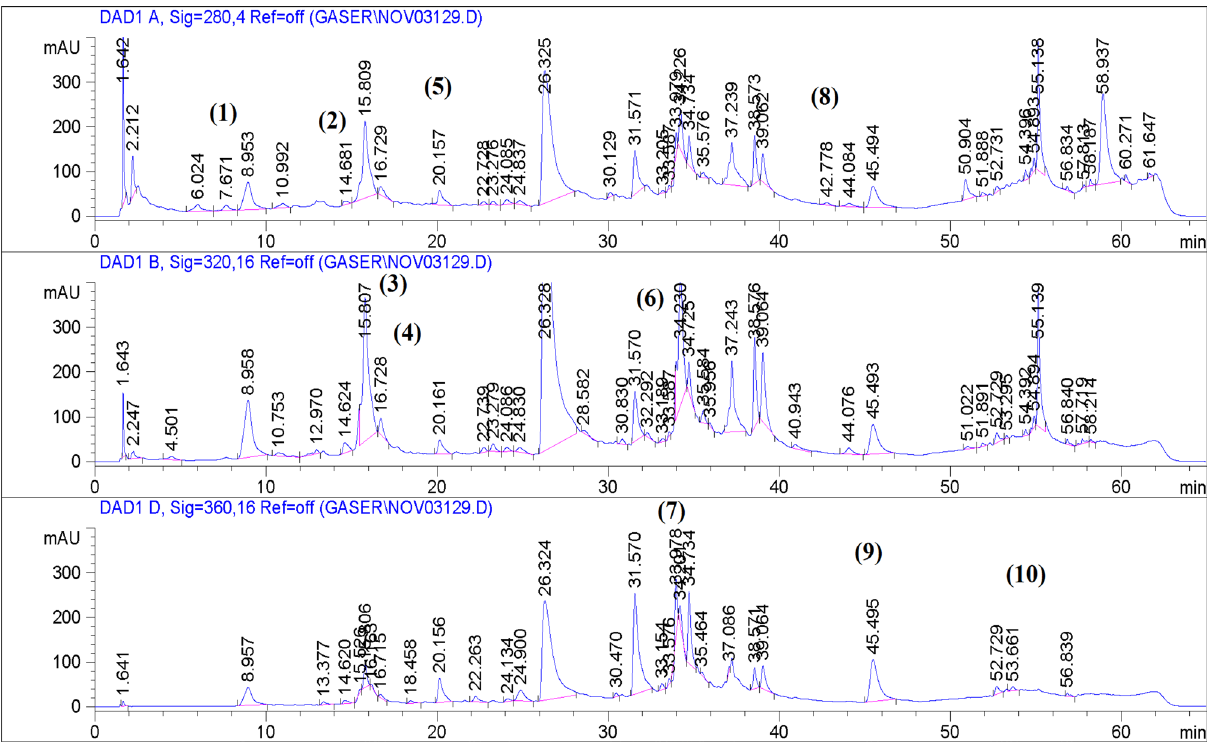
Figure 1. HPLC chromatogram of L. hispidulus ethanolic extract.